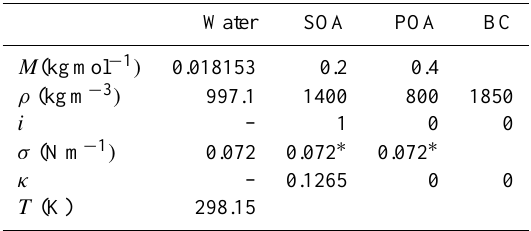
Table 2. Input values for CCN modelling. The values for SOA and POA are independently retrieved from measurements, modelling and previous studies (see references in